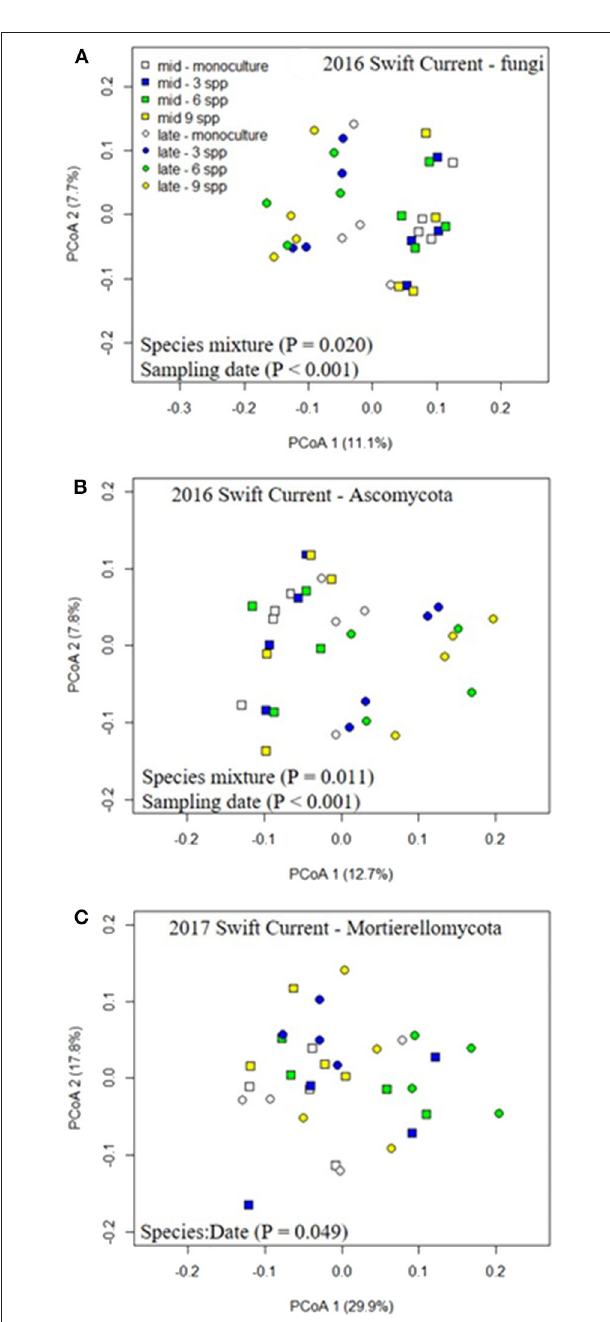
FIGURE 3 | Principle coordinate analysis (PCoA) demonstrating the effects of cropping mixtures (monoculture, three, six, and nine spp.) and date of sampling (mid or late growing season) on the community composition of the (A) fungi, (B) ascomycota, and (C) mortierellomycota at the Swift Current research site in 2016 (A,B) and 2017 (C) .